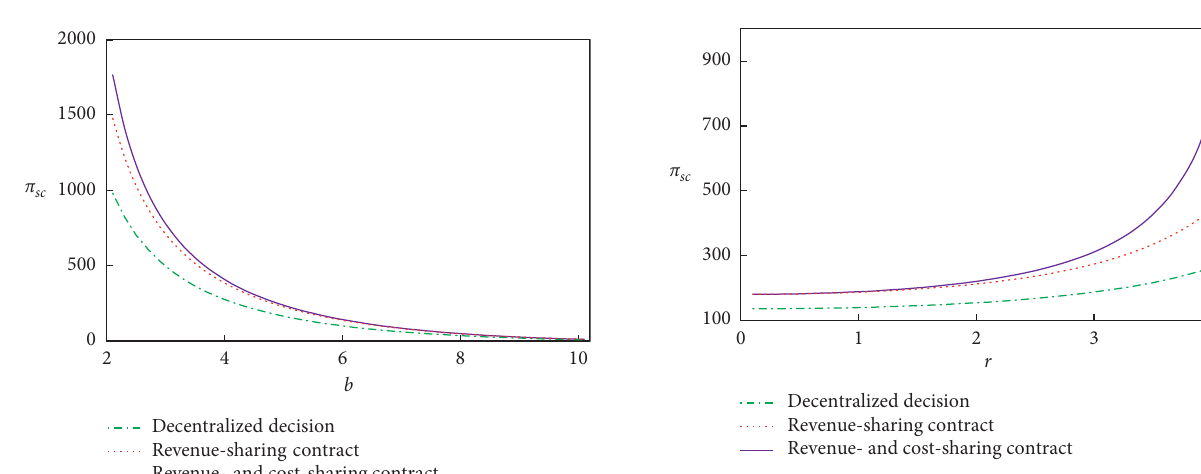
Figure 6: Impact of consumer occupational health and safety sensitivity coefficient on supply chain profits.